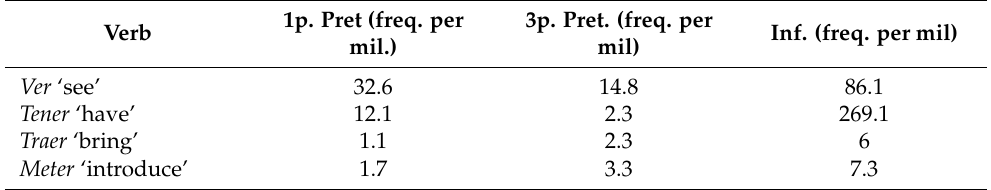
Table 4. Average relative frequencies by person and verb (CESA).